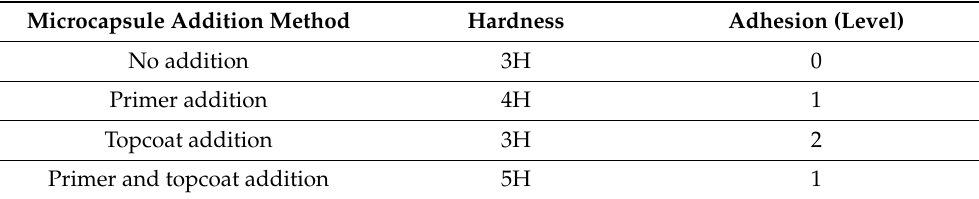
Table 7. Effect of adding methods on hardness and adhesion of paint film. Microcapsule Addition Method Hardness Adhesion